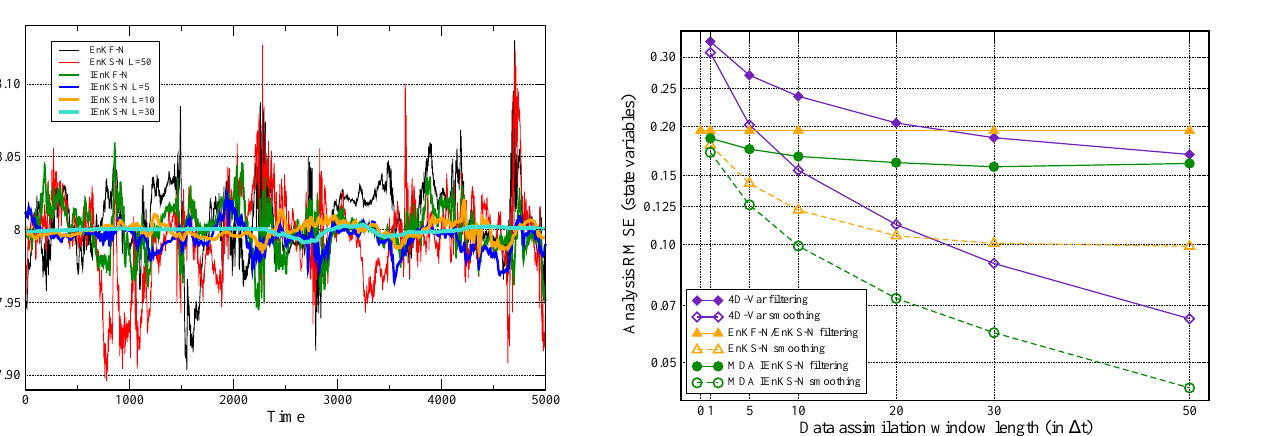
Fig. 7. Root mean square errors for the analysis of F at present time (filtering) or the retrospective analysis of F (smoothing) for the EnKF, EnKS and the IEnKS, in the case of the Lorenz-95 model, with ∆ t =0 . 05 .